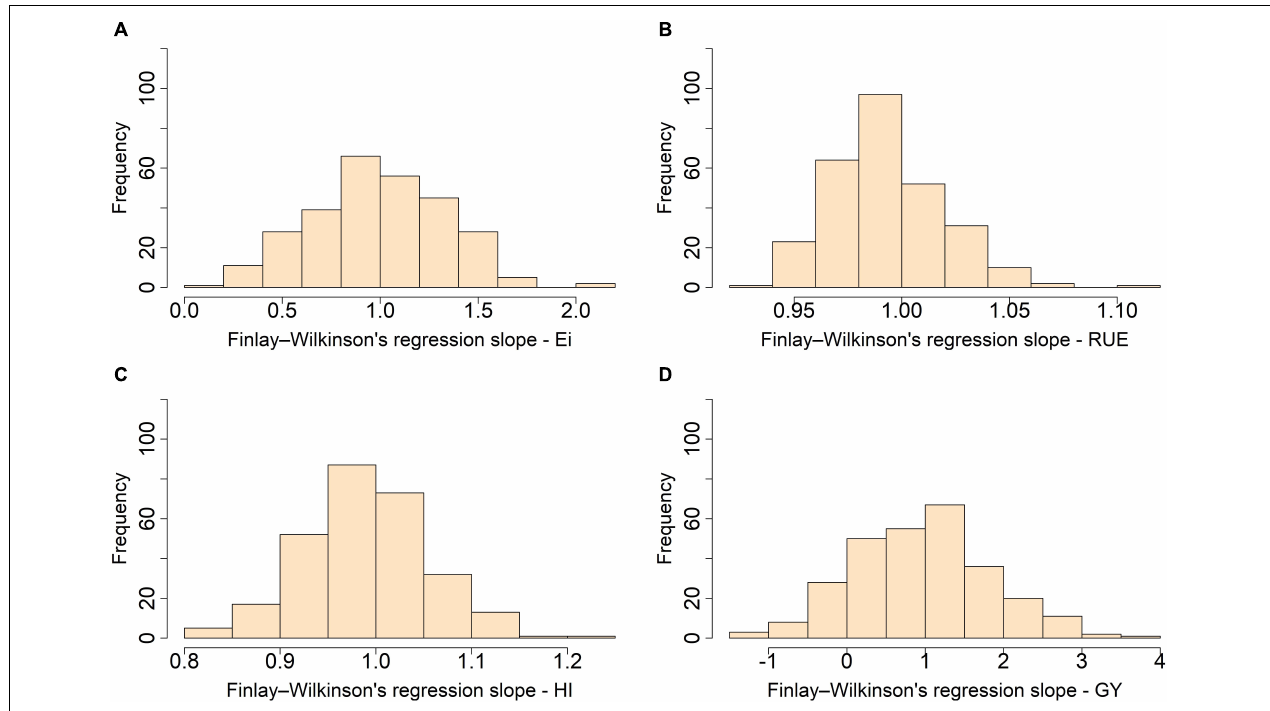
FIGURE 3 | Trait stability evaluated through the distribution for the slope from Finlay and Wilkinson joint regression for light interception efficiency (Ei) (A) , radiation use efficiency (RUE) (B) , harvest index (HI) (C) , and grain yield (GY) (D) in a maturity-controlled panel of soybean. Two hundred eighty-one recombinant inbred lines (RILs) evaluated in three